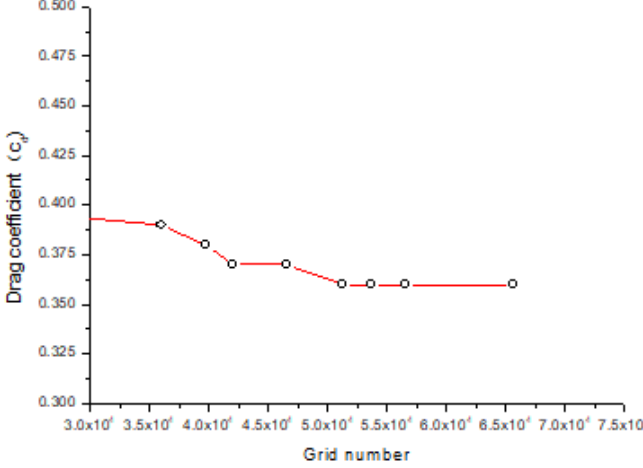
Figure 2. Drag coefficient versus grid number (Inlet velocity: 30